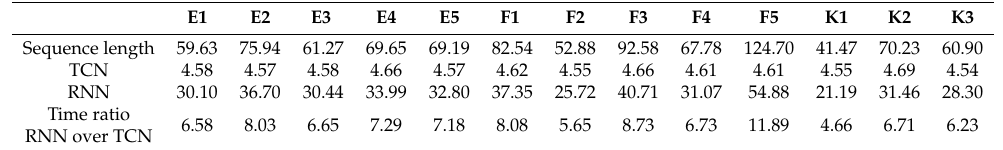
Table 16. Time consumption during 300 iterations for training each algorithm based on Coordinate-A method (unit of time: seconds, batch size = 10, measurement by RTX 2080-Ti GPU). E, F, and K denote English, freestyle, and Korean patterns, respectively.